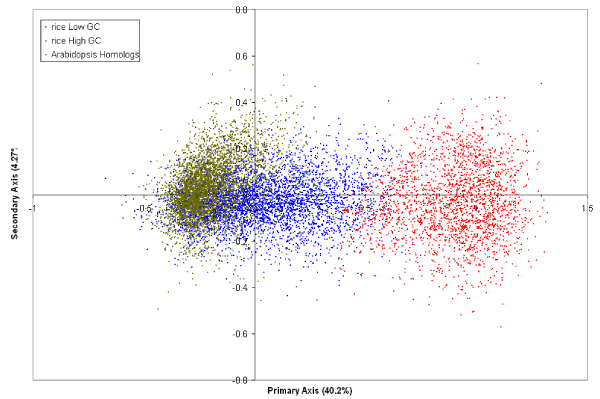
Correspondence Analysis of relative synonymous codon usage (RSCU) for 7,160 homologous gene pairs from rice and Arabidopsis. The Figure shows the distribution of genes on the primary and secondary axes (accounting for 40.2% and 4.2% of the total variation, respectively). High GC rice genes are shown in red; Low GC rice genes are shown in blue; the Arabidopsis homologs are shown in yellow.